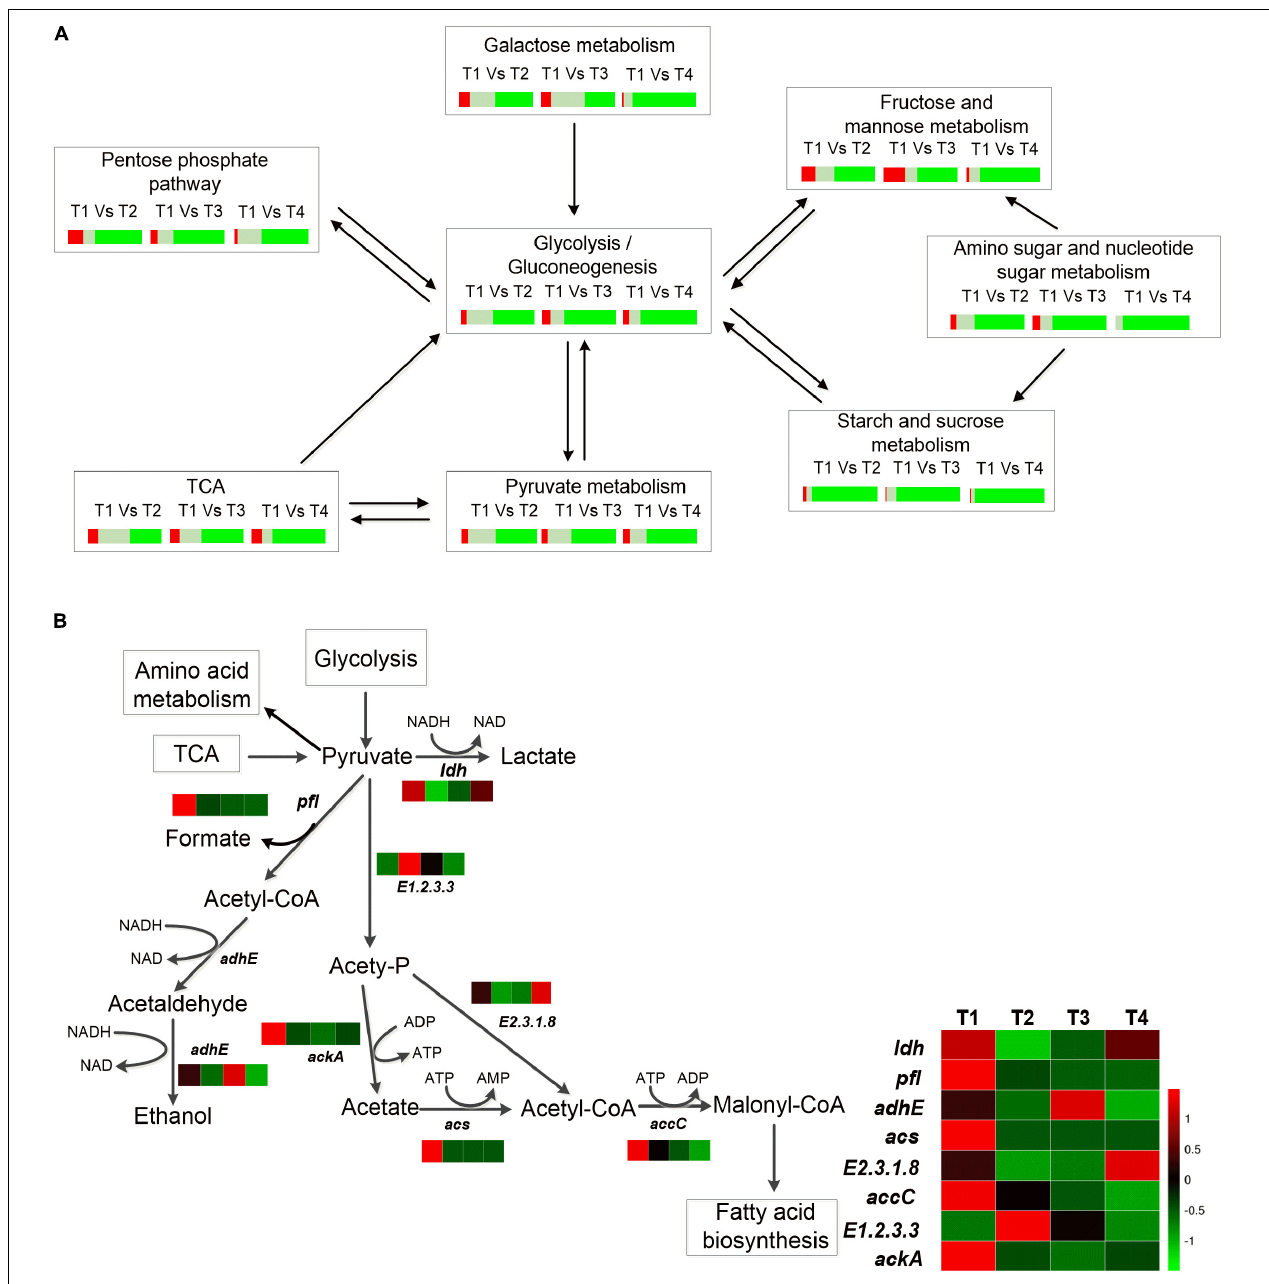
FIGURE 2 | (A) Percentage of DEGs of different carbohydrate metabolic pathways. Red represents the percentage of significant upregulated genes (log 2 ratio (cid:61) 1); gray represents the percentage of insignificant expression genes (-1 < log 2 ratio < 1), and green represents percentage of significant downregulated genes (log 2 ratio (cid:53) − 1). (B) Heat map of the DEGs of pyruvate metabolism of ST-MZ-2 during culture.